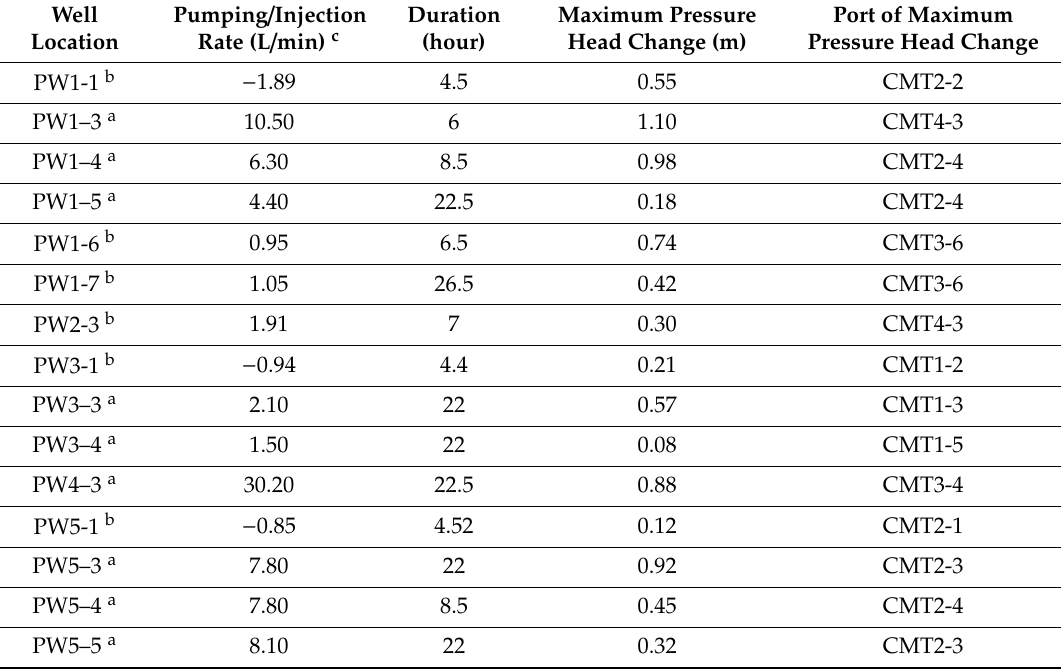
Table 1. Summary of Pumping / Injection Tests Performed at the North Campus Research